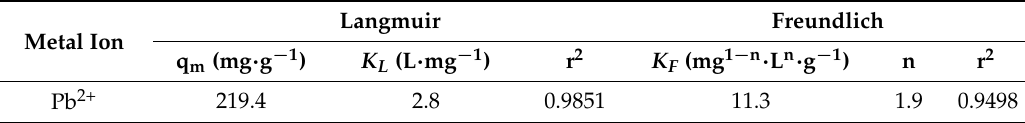
Table 4. Langmuir and Freundlich parameters for Pb(II) adsorption on g-PAM/OVerm.